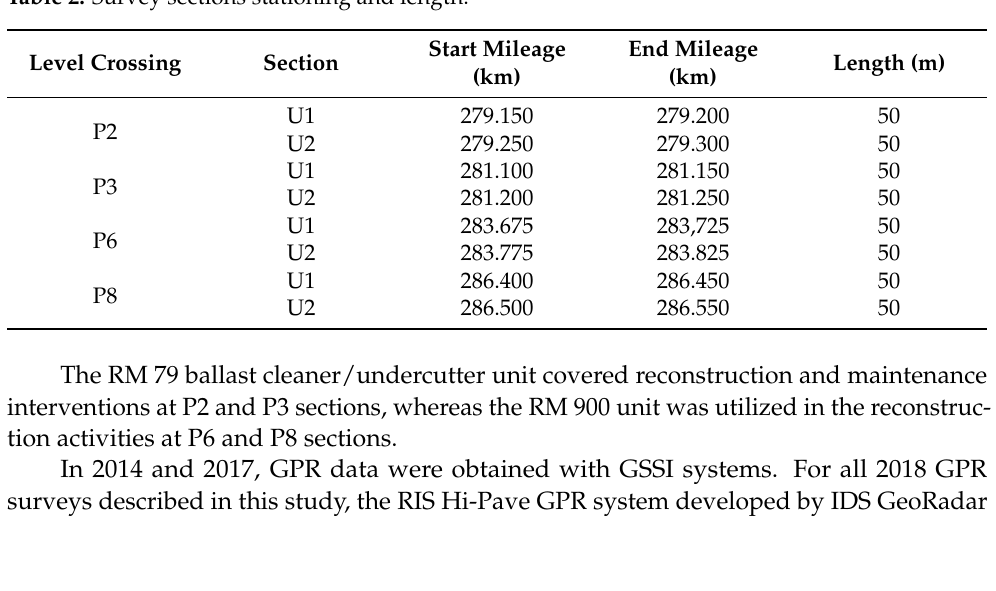
Figure 3. Ground Penetrating Radar (GPR) trolley designed for the surveys (air-coupled antenna in diagonal orientation). 3. Track Surveys, Laboratory Tests, and GPR Data Processing The present study covered both field and laboratory tests. The GPR field surveys were adjusted according to the timetable of the rehabilitation activities in the construction